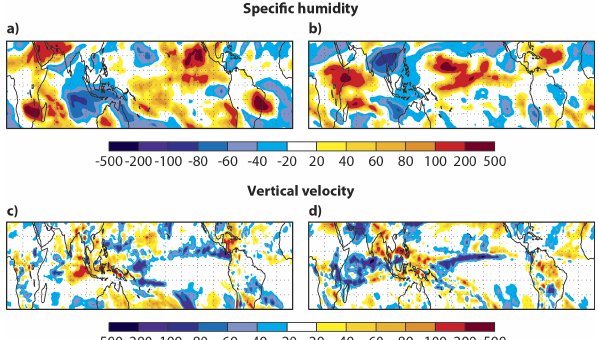
Figure 15. TCO 3 differences in percent for October (left) and December (right) from the experiments BASE06–BASE05 (top), BASE06–CLIM06 (middle) and CLIM06–CLIM05 (bottom). The top panels show the overall differences of TCO 3 due to the com- bined effects of El Niño-related dynamical changes and changes in the fires emissions between El Niño and normal conditions. The middle panels show the impact of changes to the fire emissions un- der El Niño conditions, and the bottom panels show the impact of the El Niño-induced dynamical changes on TCO 3 when climato- logical fire emissions are used for both years. Red colours indicate positive values and blue colours negative values.